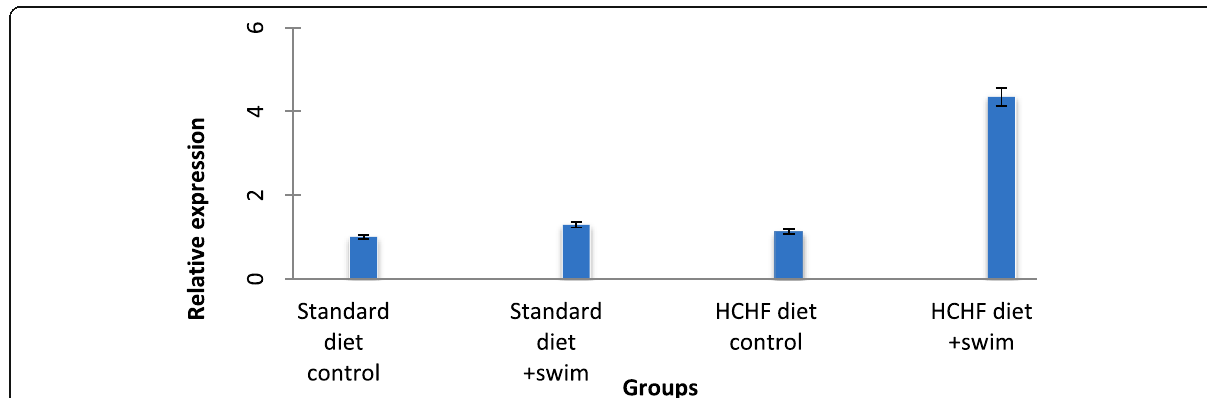
Fig. 1 Relative fold change of muscle FNDC5 mRNA expression in different studied